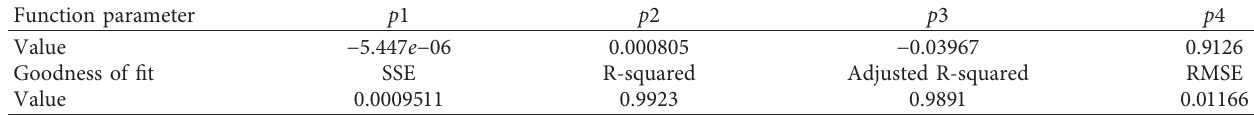
Table 3: The parameters of the polynomial linear